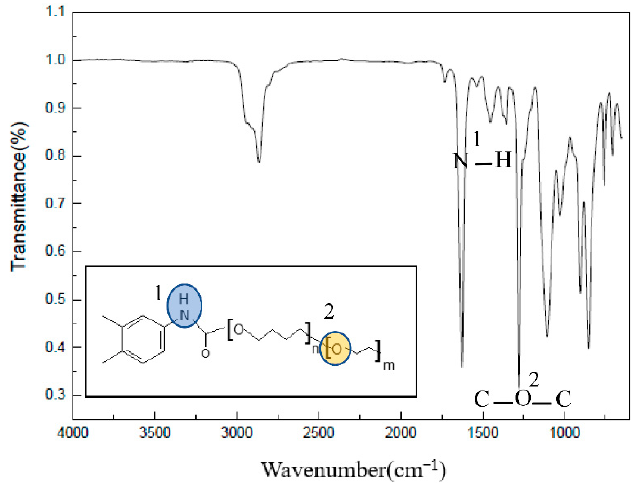
Figure 11. The infrared spectrum of HTPE film at room temperature.